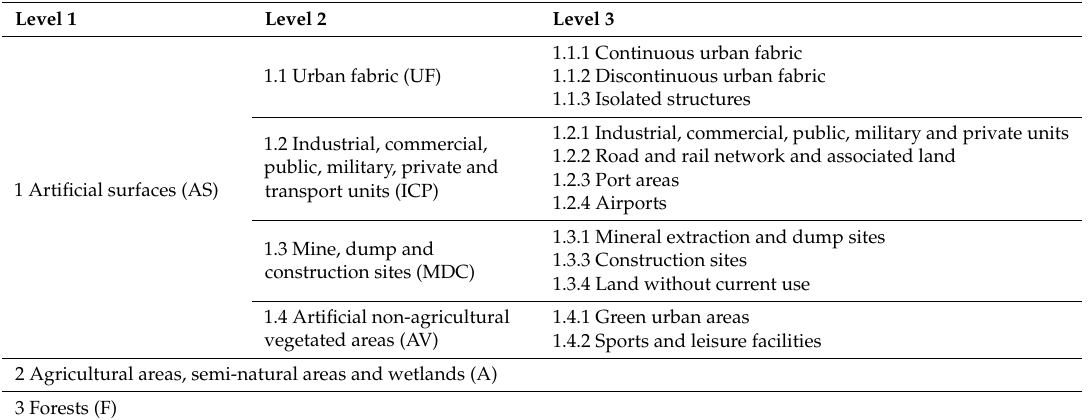
Table 2. Nomenclature of the Urban Atlas